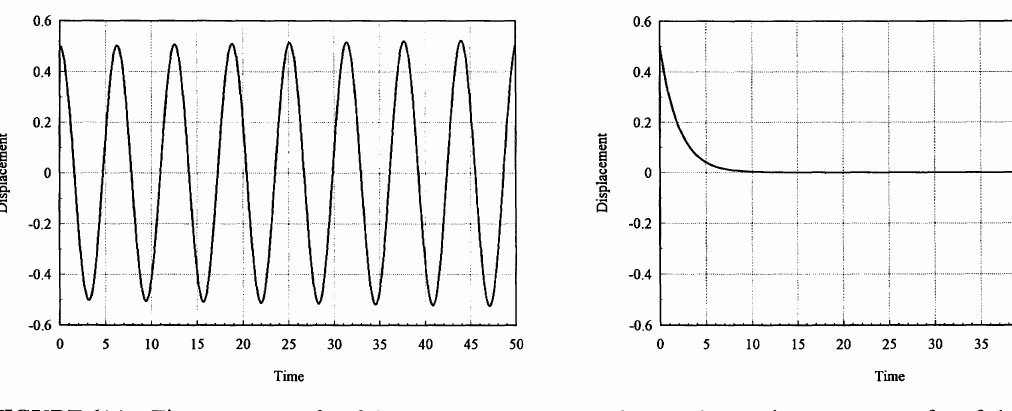
FIGURE 7(b) Trajectory of the controlled prism in the phase plane showing the sliding line, y(O) = 0.5, U =